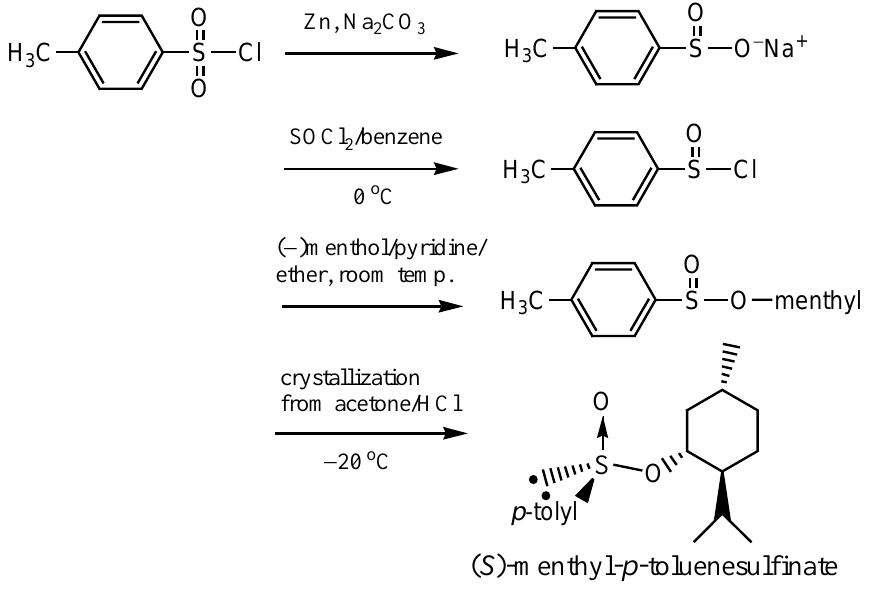
Scheme 1 . Preparation of ( S )-menthyl- p